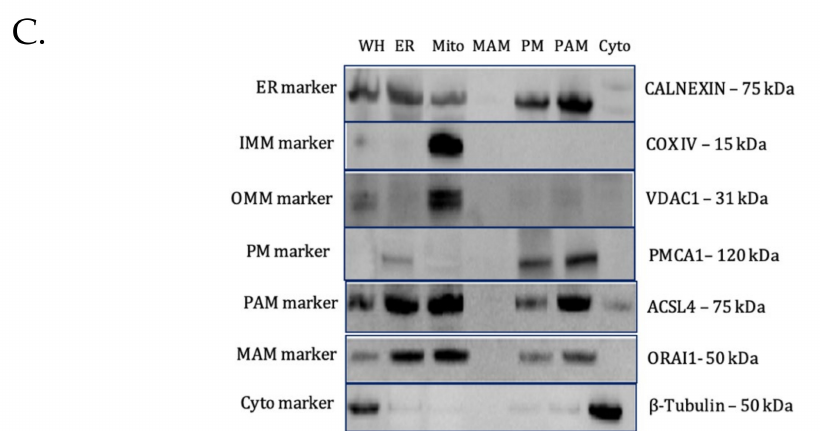
Figure 2. Subcellular fractionation and analysis of lipid enrichment. ( A ) Schematic representation of the protocol used for isolation of crude PM/PAM, ER/cytosol, and mitochondria/MAM fractions from MA-10 cells. ( B ) The crude PM/PAM fraction from ( A ) was further subjected to fractionation to generate pure PM, PAM, ER, cytosol, mitochondria, and MAM fractions. ( C ) Proteins from isolated organelles were subjected to immunoblot analysis to determine the purity of the samples by using antibodies to the following markers for the specified organelle: PM Ca(2+)-ATPase 1 (PMCA1) (120 kDa) for the PM, voltage-dependent anion channel (VDAC) for the outer mitochondrial membrane (OMM), β -tubulin for the cytoplasm, cytochrome c oxidase subunit IV (COX IV) for the inner mitochondrial membrane (IMM), calnexin for the ER, acyl-coenzyme synthetase long-chain family member 4 (ACSL4) for PAMs, and ORAI calcium release-activated calcium modulator 1 (ORAI1) for